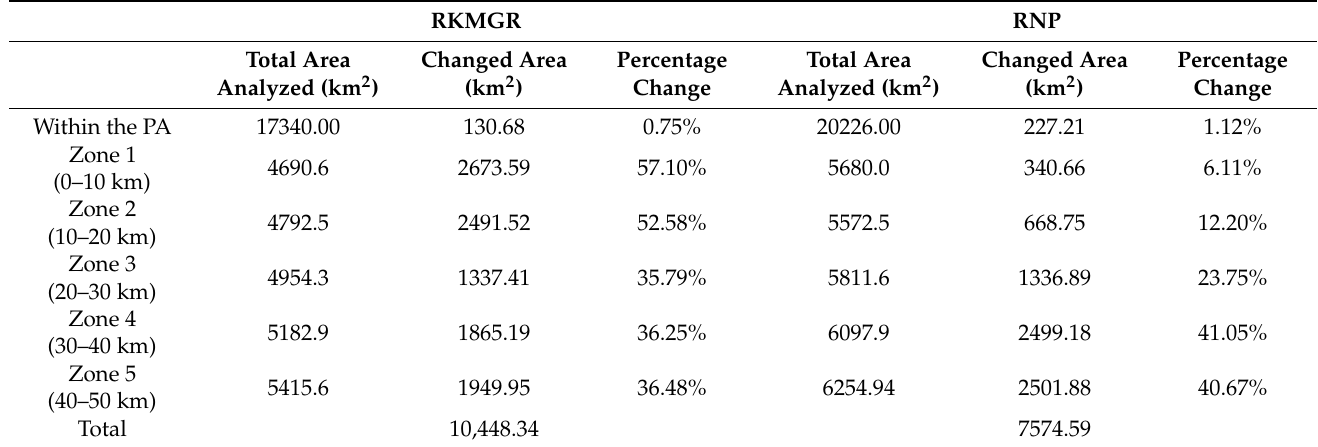
Figure 5. Spatial pattern and the year of the change occurrence in the Ruaha–Rungwa landscape from 2000 to 2019: (1), (2), (3), (4), and (5) are magnifications of prevalent disturbances; and (1) and (2) are the areas that were used for the accuracy assessment (highlighted in Figure 4). Table 2. Changed savannah areas in each zone during the monitoring period (2000–2019) . RKMGR